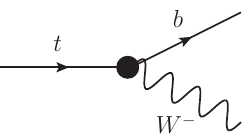
Figure 1: Feynman diagram of the Wtb transition. The black circle denotes the vertex which can contain anomalous